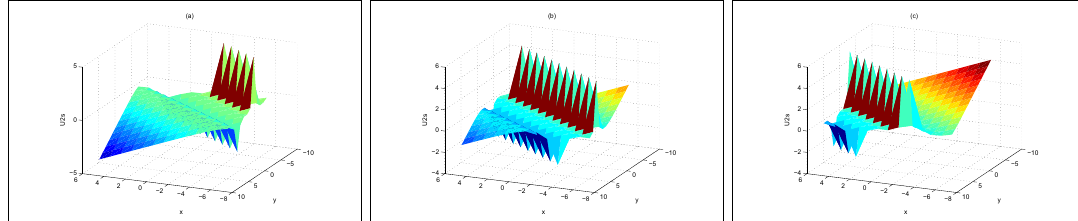
Figure 2: The solution of the ( 2 + 1 )- dimensional gCBS equation corresponding to ( ) U z s 1 , ( a ) = t −3 , ( b ) = t 0 and ( c ) = t 3 .